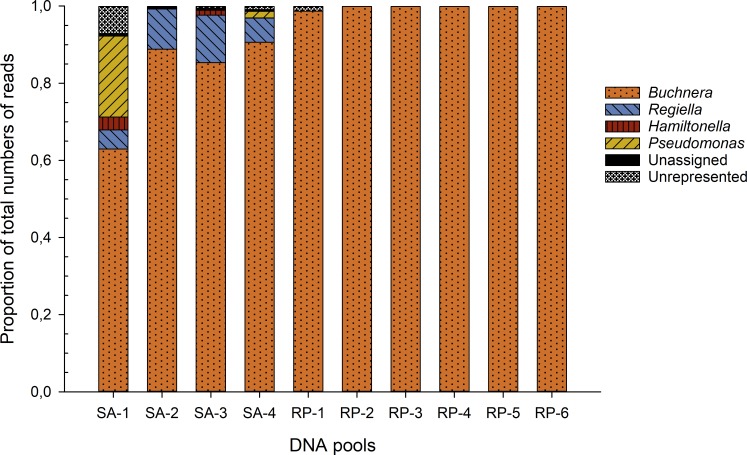
Summary of 16S rRNA gene sequencing-based taxonomic assignments.Proportion of taxa assignments for each DNA pool of S. avenae (SA-1, SA-2, SA-3 and SA-4) and R. padi (RP-1, RP-2, RP-3, RP-4, RP-5 and RP-6). The proportion of sequences assigned to <1% of the total reads per sample are identified as ‘unrepresented’, and sequences that did not cluster with any known sequences are identified as ‘unassigned’.